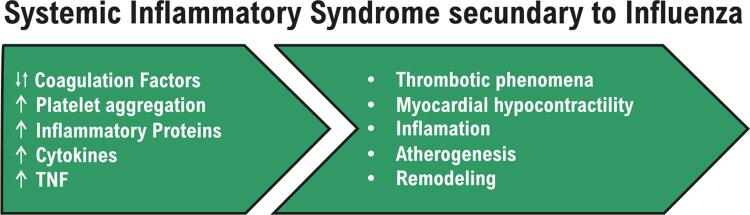
– Pathophysiology of cardiovascular changes secondary to systemic inflammation in Influenza infection. Source: The authors.